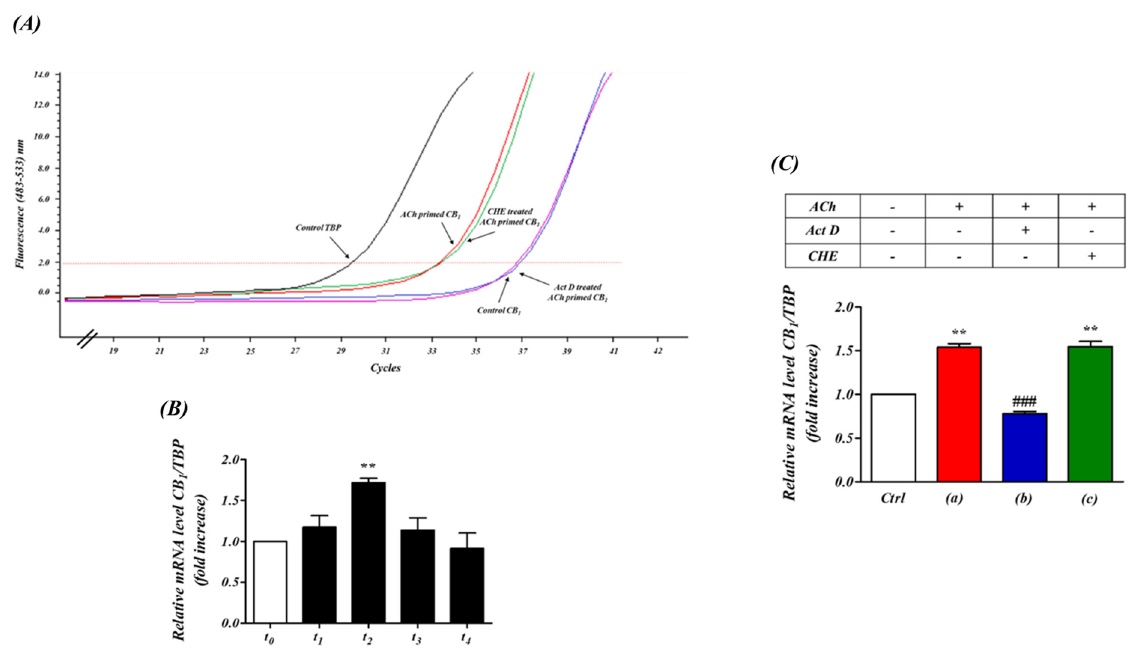
Figure 4. ACh ‘priming’ enhances the transcription of CB 1 receptor acting on the CNR1 locus in SH − SY5Y human neuroblastoma cells. ( A ) qPCR amplification curves of mRNA CB 1 receptor level (CNR1 locus) in human neuroblastoma SH − SY5Y cells. The effects of ACh, Act D and CHE on mRNA CB 1 receptor levels are indicated by arrows. ( B ) Time course of the effect of M 3 receptor stimulation on the mRNA CB 1 receptor level in human neuroblastoma cell line. t 0 : 0 min; t 1 : 2.5